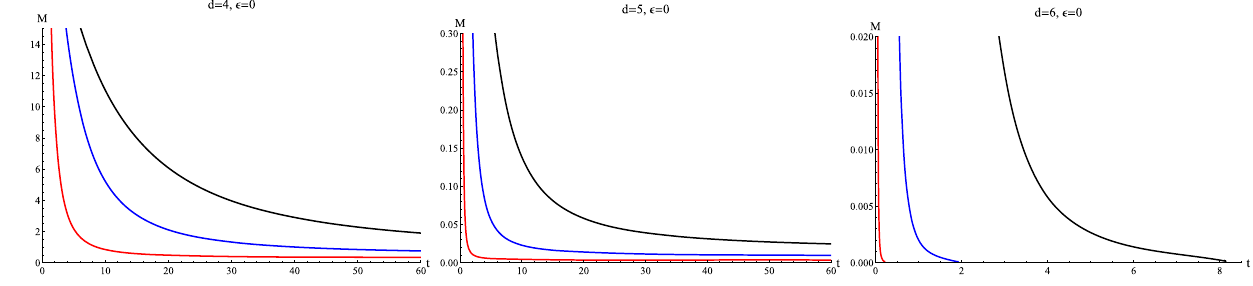
Fig. 2 The evolution of the black hole in d = 4 , 5 , 6 and (cid:2) = 0. The initial mass M 0 is taken to infinity. In each figure from left to right the curves correspond to (cid:3) = 0 . 1, (cid:3) = 0 . 15 and (cid:3) = 0 . 2 respectively